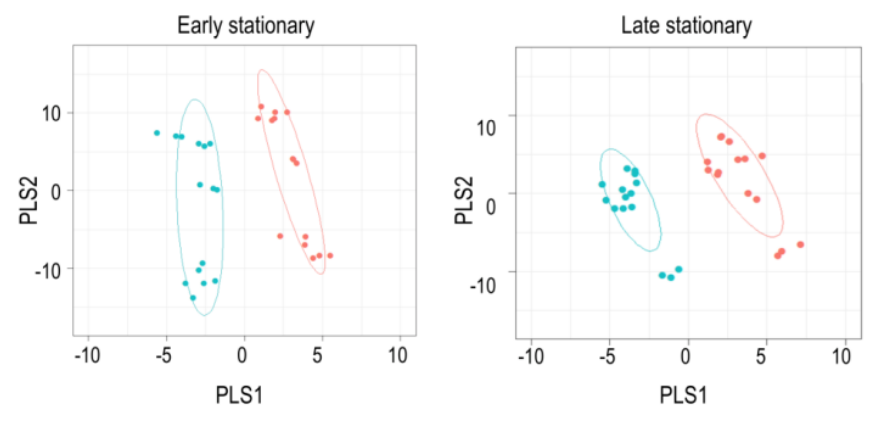
FIGURE 2: PLSDA of WT and purH mutant metabolomes. Untargeted metabolomics was performed on wild-type and purH mutant of S. enterica grown in glucose minimal medium supplemented with